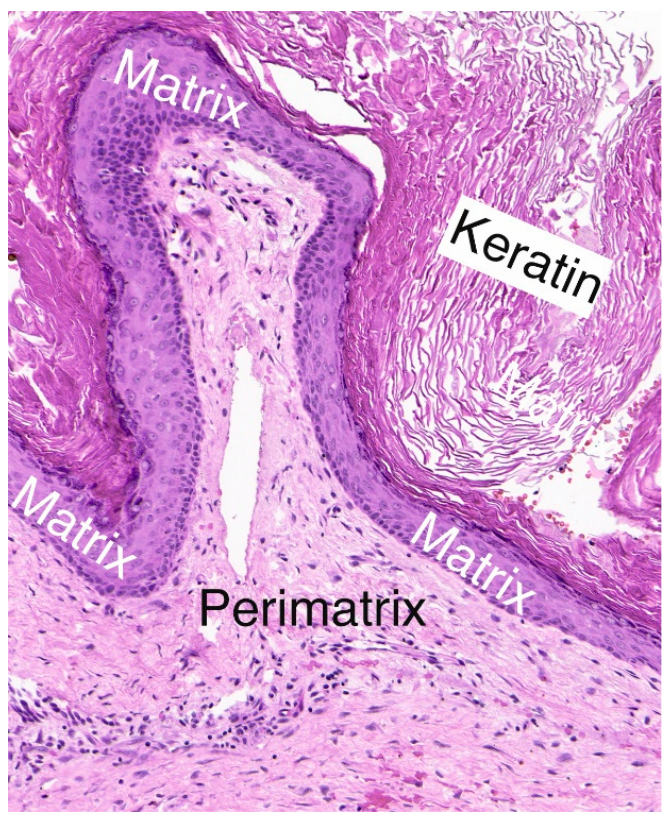
Figure 1. Paraffin section of a cholesteatoma specimen stained with hematoxylin and eosin (H&E) showing the two histological layers of cholesteatoma: the squamous epithelial layer (matrix) and the underlying stromal lamina propria (perimatrix). The cyst contains keratin lamellae.